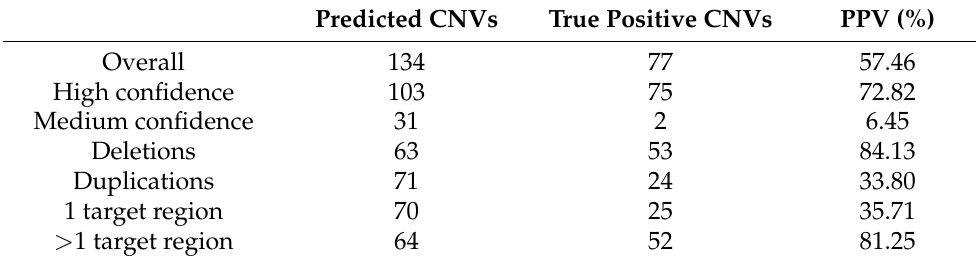
Table 1. Results of the Sophia Genetics DDM CNV predictions according to the confidence level provided by the Sophia Genetics DDM software, type of CNV, and the number of adjacent target regions affected. CNV predictions were considered as predictions with high confidence if at least one of the included target regions was predicted with high confidence. PPV = positive predictive value.